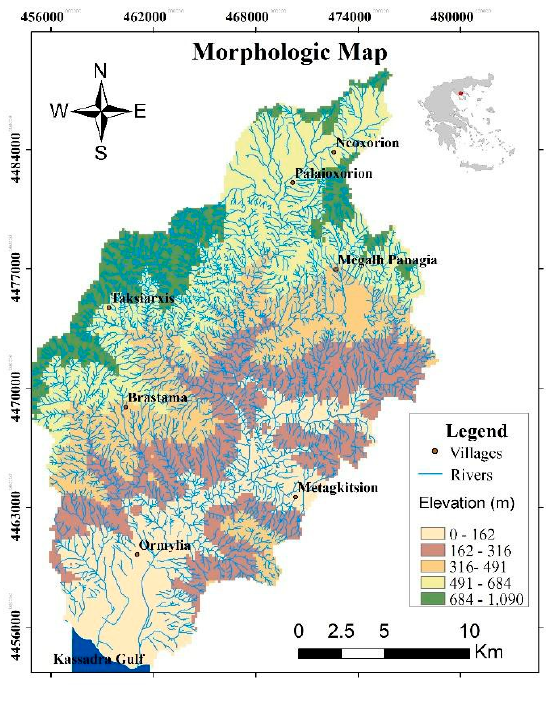
Figure 1. The morphological map of the Havrias river